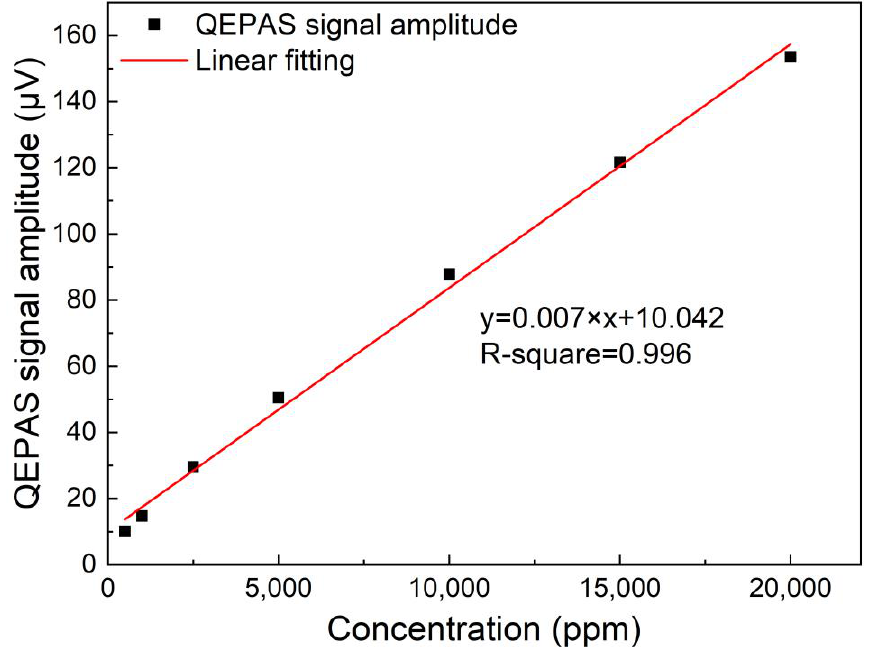
Figure 9. Concentration response of CH 4 -QEPAS sensor with 3D-printed ADU.